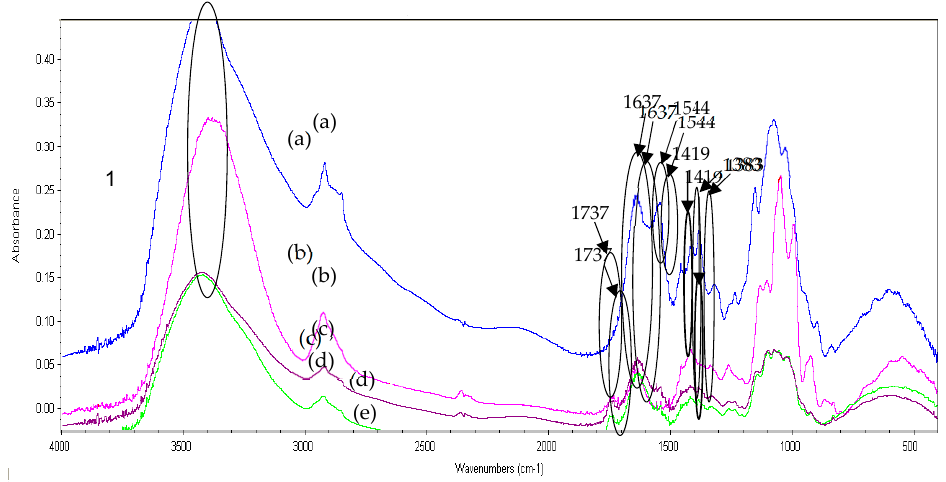
Figure 4. Fourier transform infrared (FTIR) spectra of nanochitosan film (a), P:NCS 50:50 film (b), P:NCS 75:25 film (c) and pectin film (d).